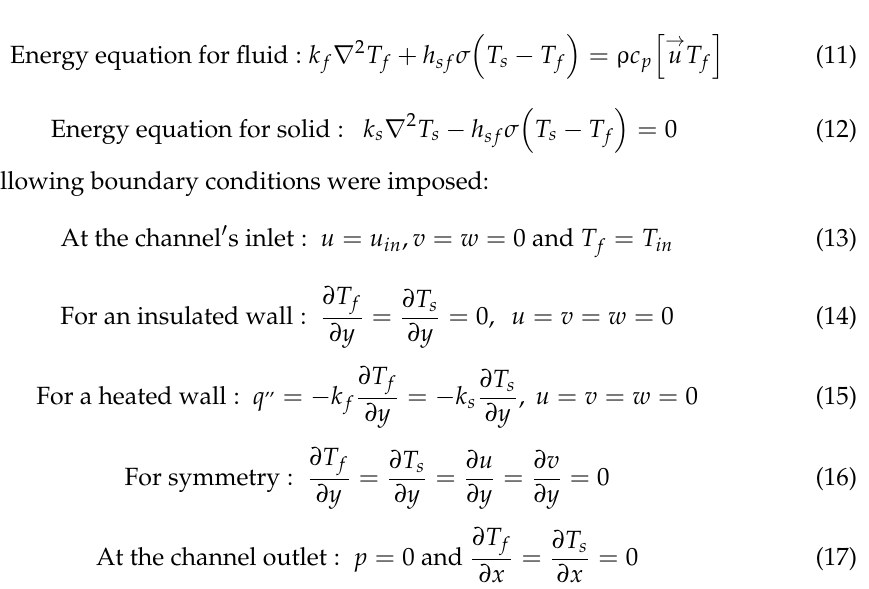
Figure 1. Solution domain for preliminary study.